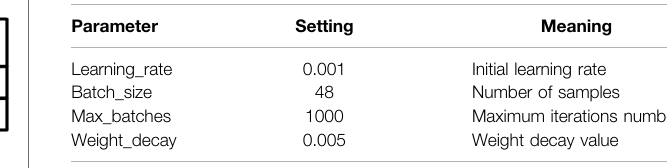
TABLE 2 | Faster R-CNN training